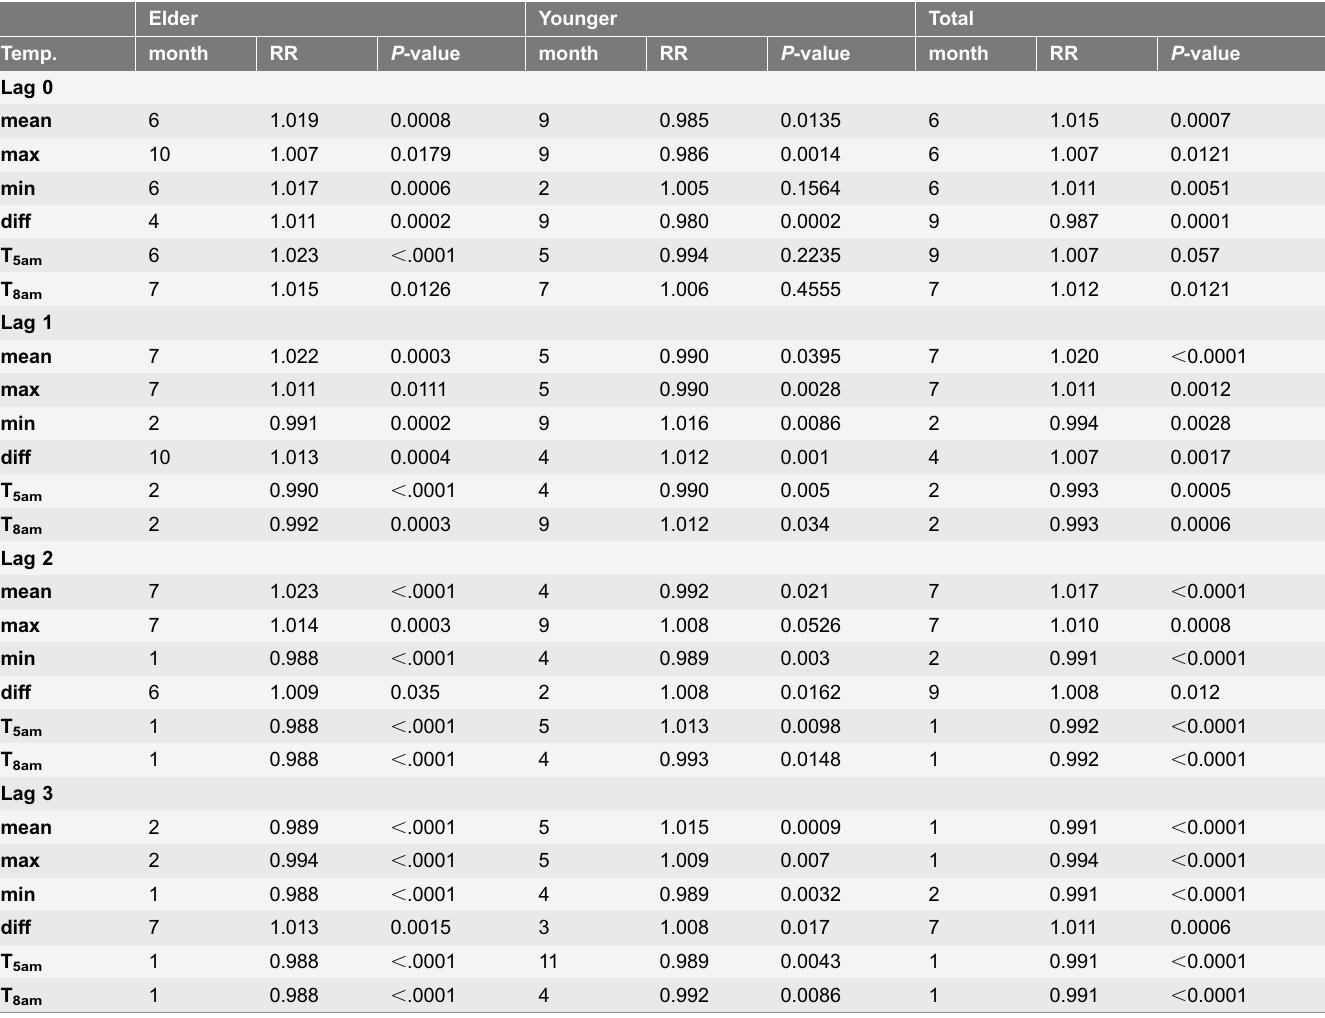
Table 2. Relative risk of temperature on mortality adjusted for O 3a